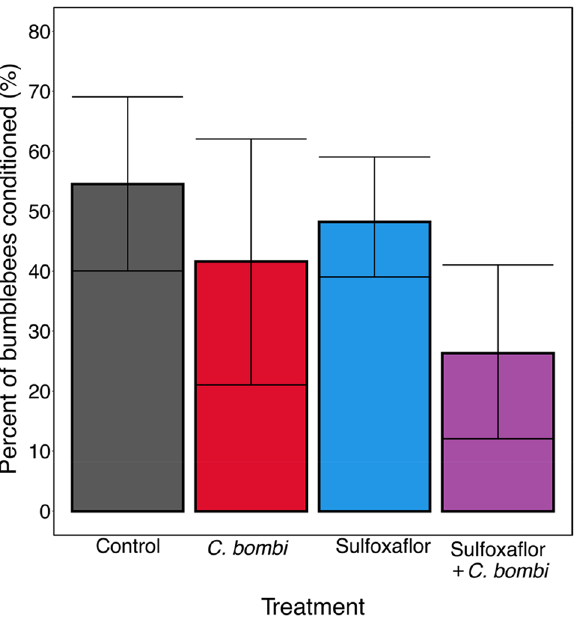
Figure 1. Responsiveness. The proportion of workers that showed a conditioned response in each treatment group ± 95% confidence interval (control n = 44; sulfoxaflor n = 56; C. bombi n = 24; sulfoxaflor + C. bombi n =